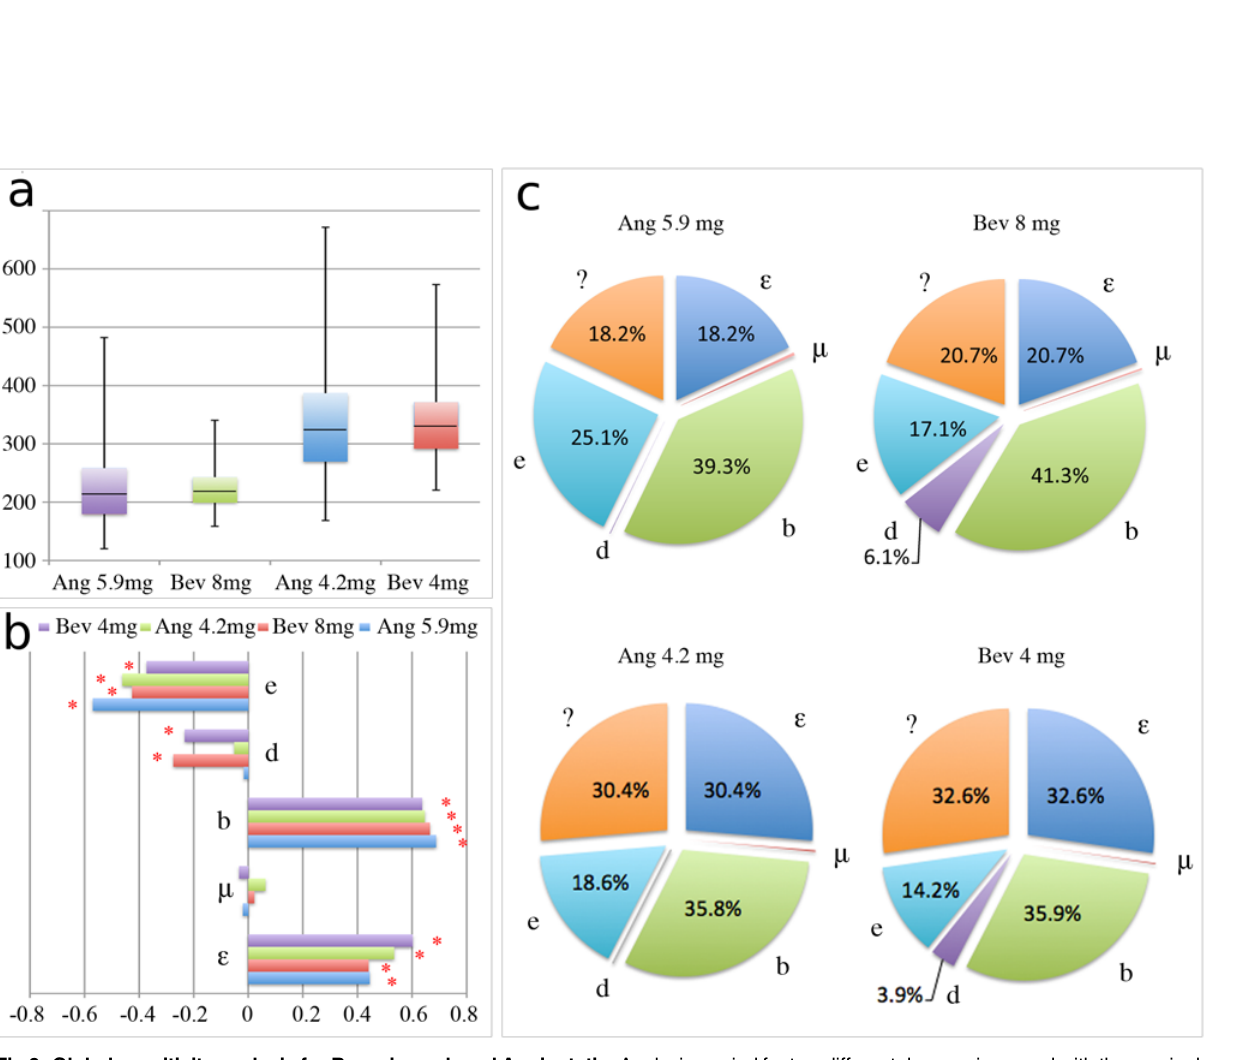
Shown are the exact values of pharmacokinetic parameters (e, clr) and doses (D) for which the original model (TNP-470, Endostatin, Angiostatin) and the modi fi ed one (Bevacizumab) give the same tumor volume at the end of treatment. Values of pharmacokinetic parameters, except for bevacizumab, were estimated in [7].